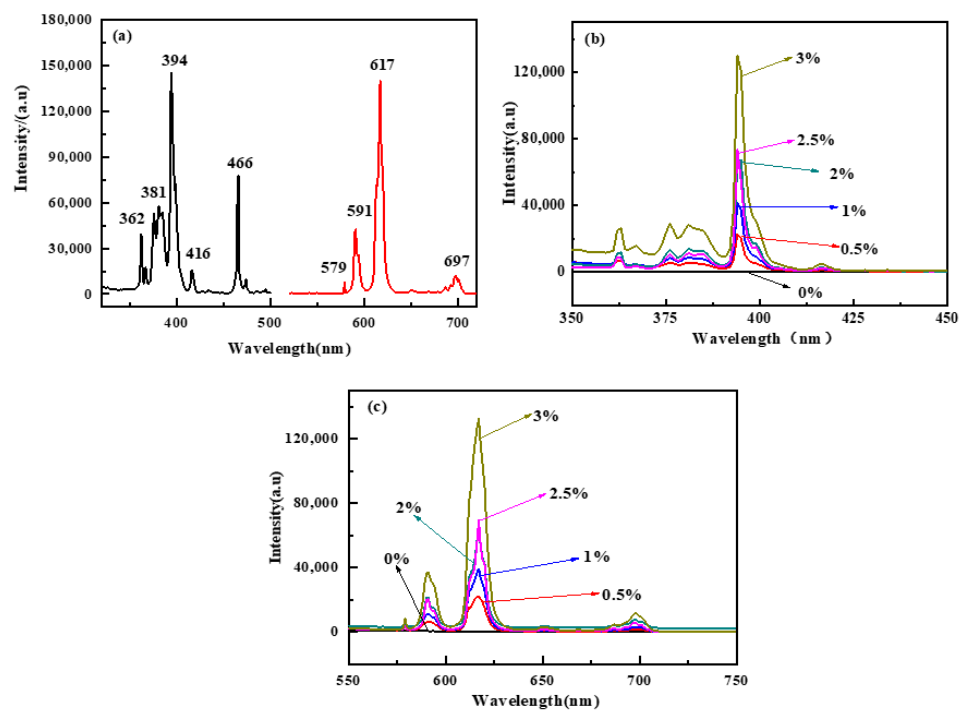
Figure 6. Excitation spectra with an emission wavelength of 617 nm and emission spectra at an excitation wavelength of 394 nm of the europium complex powders ( a ) and polyurethane–europium materials with different mass contents of europium complex ( b , c ) at room temperature.